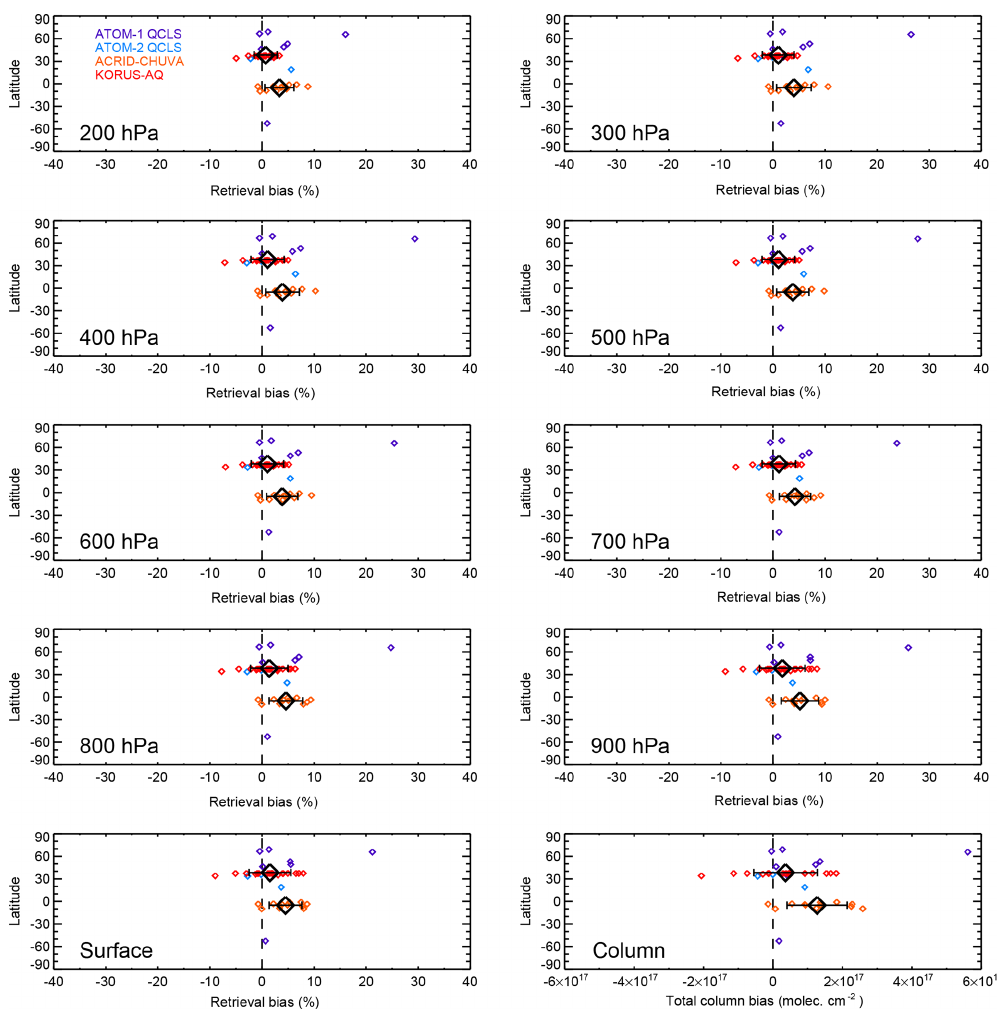
Figure 10. V8 NIR-only biases based on the ATom, ACRIDICON, and KORUS-AQ CO